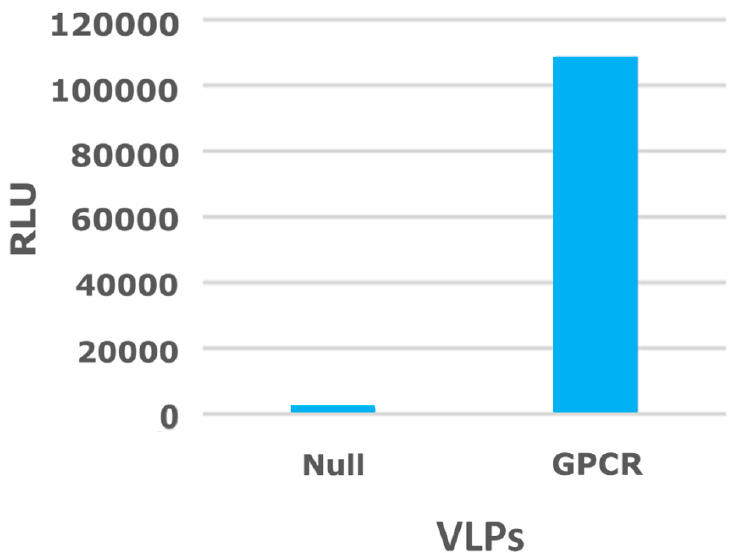
Figure 4. Binding of an antibody to virus-like particles (VLPs) that express a G-protein coupled receptor (GPCR). A mouse monoclonal antibody was tested for binding to biotinylated null VLPs or biotinylated VLPs expressing a GPCR. VLPs were incubated with streptavidin-coated magnetic beads and blocked with milk. The monoclonal antibody was incubated with each VLPs attached to beads, washed with PBS + 0.01% tween (PBS-T), and then incubated with anti-mouse-Horseradish peroxidase (HRP). After final washes with PBS-T, the beads were transferred to an enzyme-linked immunosorbent assay (ELISA) plate and incubated with a chemiluminescent reagent, followed by reading of ELISA signal in a plate reader. RLU is the abbreviation for relative luminescence unit.